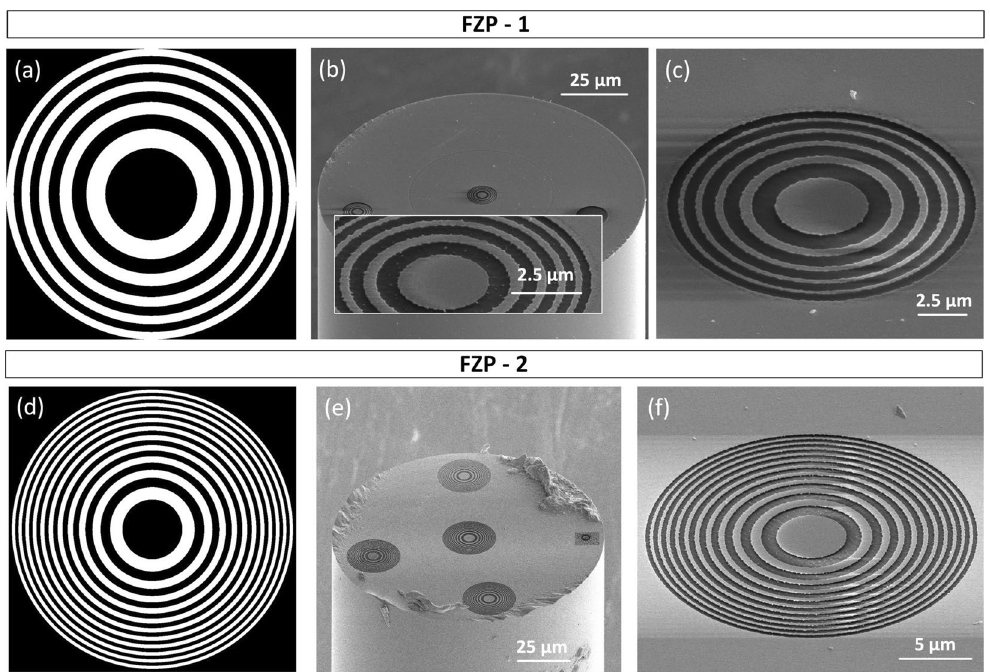
Figure 2. Fresnel zone plates: ( a ) amplitude mask used to fabricate FZP-1; ( b ) image of the optical fibre with FZP-1, (inset) zoom of a FZP fabricated with a metallic film of Au/Pd; ( c ) zoom of FZP-1; ( d ) amplitude mask used to fabricate FZP-2; ( e ) image of the optical fibre with FZP-2; ( f ) zoom of